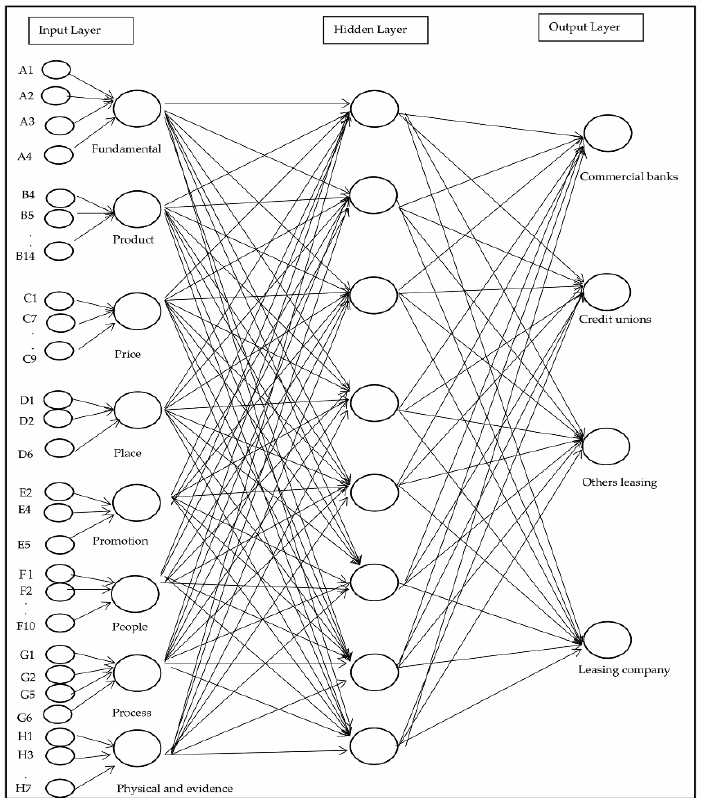
Figure A3. Structure of the NN by using Pareto technique ( 80 :20) model used for predicting.